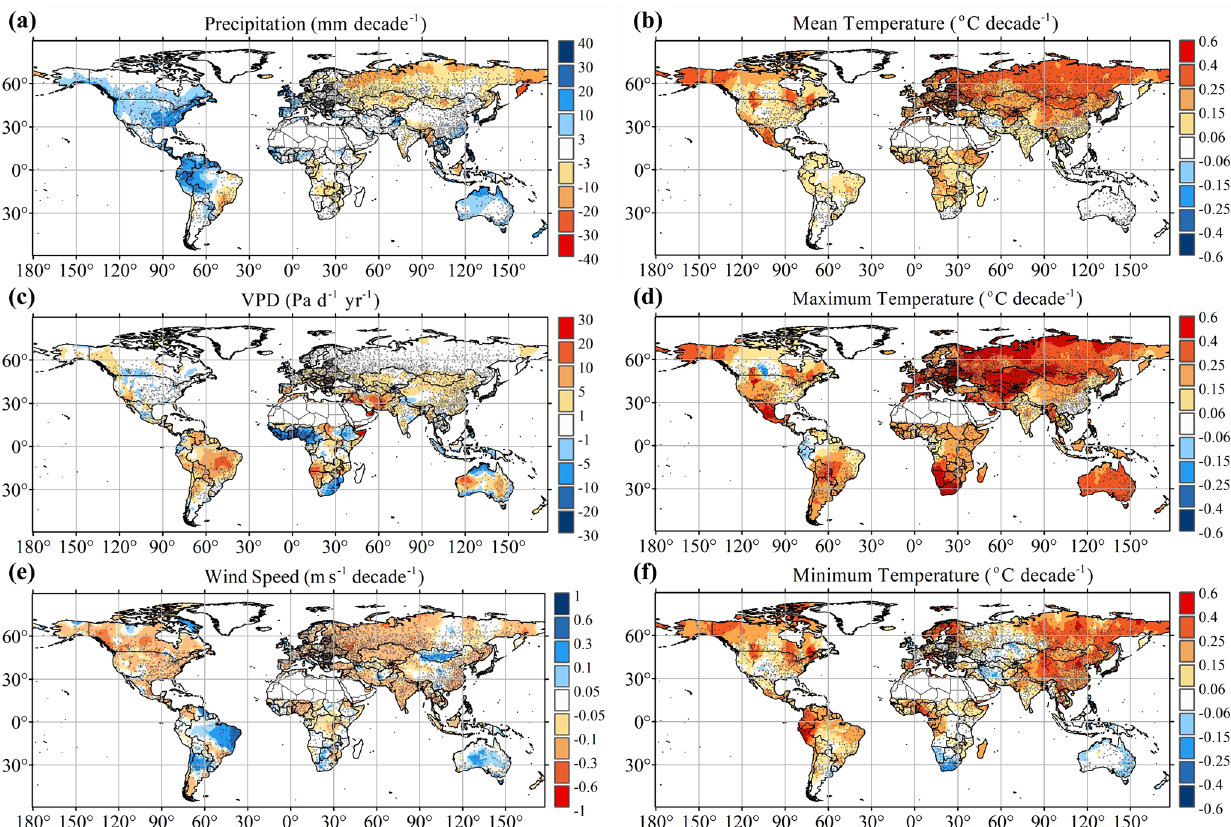
Figure 3. Long-term trends in annual precipitation, vapor pressure deficit (VPD), surface wind speed, mean temperature, maximum temper- ature and minimum temperature. Values are not shown for the Greenland and Sahara region as weather stations are scarce, and the range of the Sahara is referring to the existing study (Vicente-Serrano et al., 2015). Small gray squares show locations of the weather stations used to interpolate global